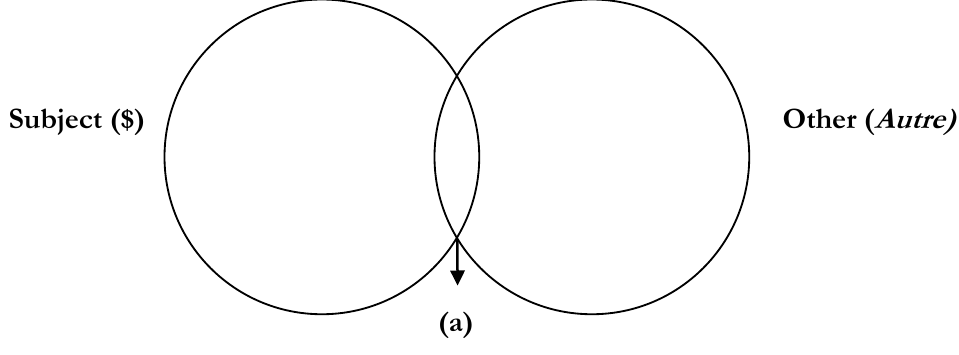
Fig. 1. The Production of the Object (a) in the Subject’s Separation from the Matthew Geary, ‘Unkind and cruel, to deceive your Son | In borrow’d Shapes, and his Embrace to shun’: Mother-son love in T. S. Eliot’s ‘La Figlia Che Piange’ Studies in the Maternal , 7(1), 2015, www.mamsie.bbk.ac.uk